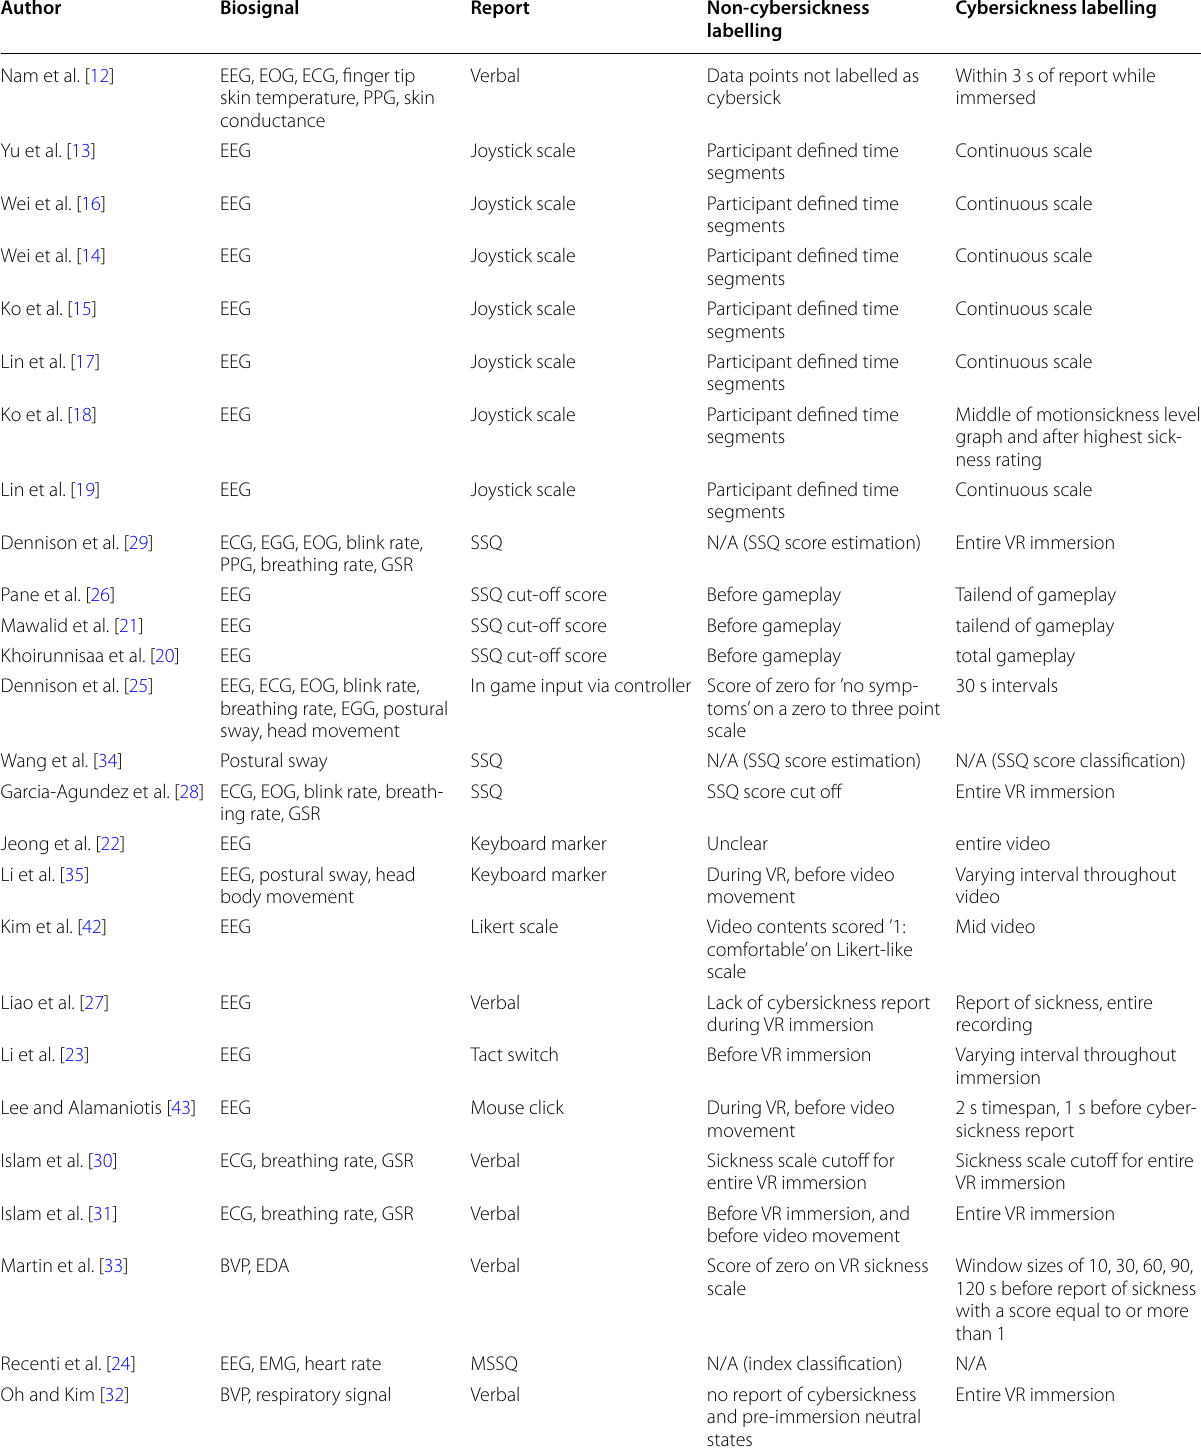
Table 6 Reporting styles and data